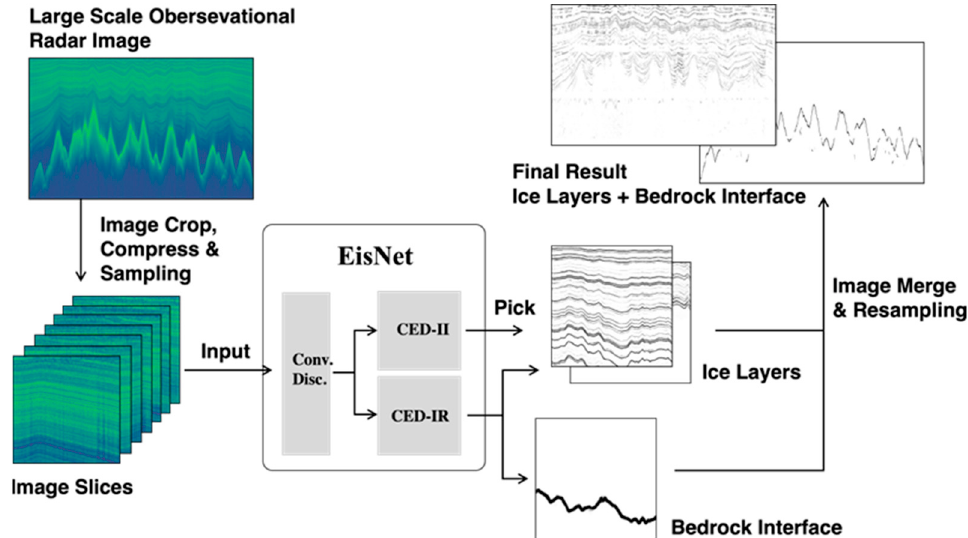
Figure 1. Workflow of EisNet extracting the internal ice layers and bedrock interface in large-scale observational radar images.